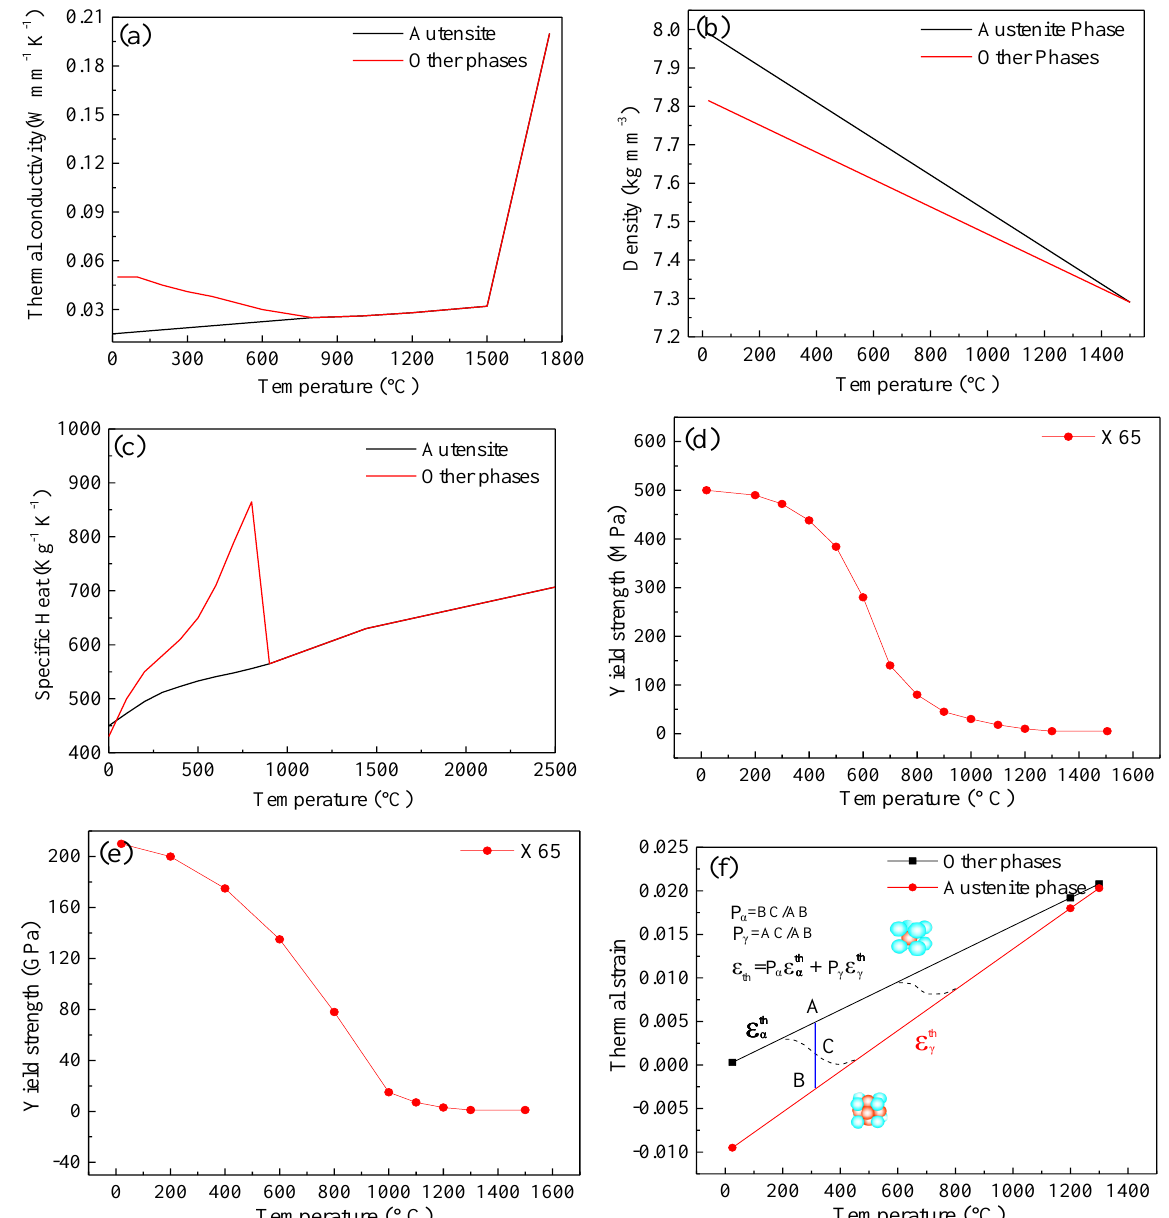
Figure 6. The material properties: ( a ) thermal conductivity; ( b ) density; ( c ) specific heat; ( d ) yield strength; ( e ) Young’s modulus; ( f ) thermal strain of